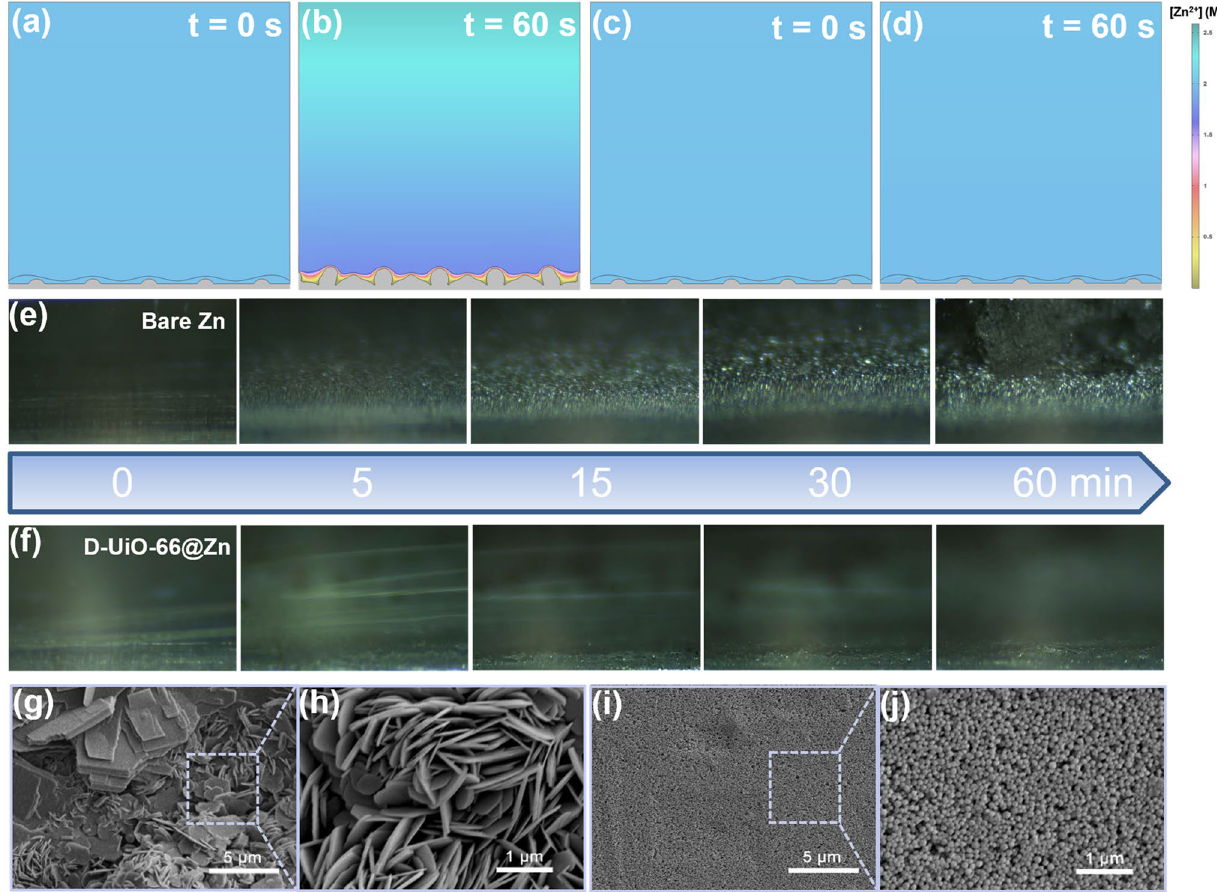
Fig. 3 a–d Simulated zinc ions concentration profiles and Zn deposition of a, b the bare Zn anode and c, d D-UiO-66@Zn anode before and after 60 s. The Zn deposition process of e bare Zn and f D-UiO-66@Zn using an in-situ optical microscope at a current density of 5 mA cm −2 . SEM images for g, h bare Zn anode and i, j D-UiO-66@Zn anode after 50 plating/stripping